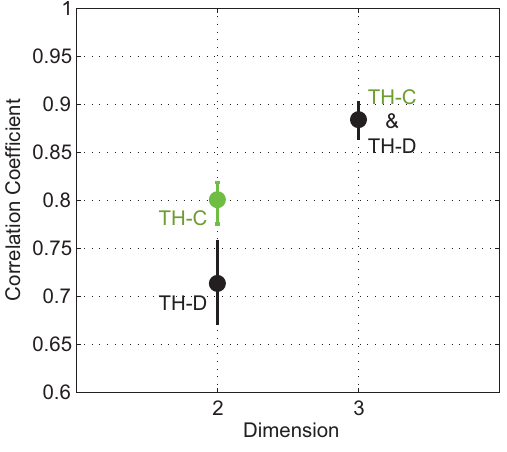
Figure 7. The correlation coefficients between the three GSM com- ponents of the predicted and measured fields at THE, and their con- fidence intervals corresponding to ± 1 sigma, for the 2-D and 3-D methods. The two correlation coefficients in the 2-D case are from the GS reconstruction applied individually to the THC and THD